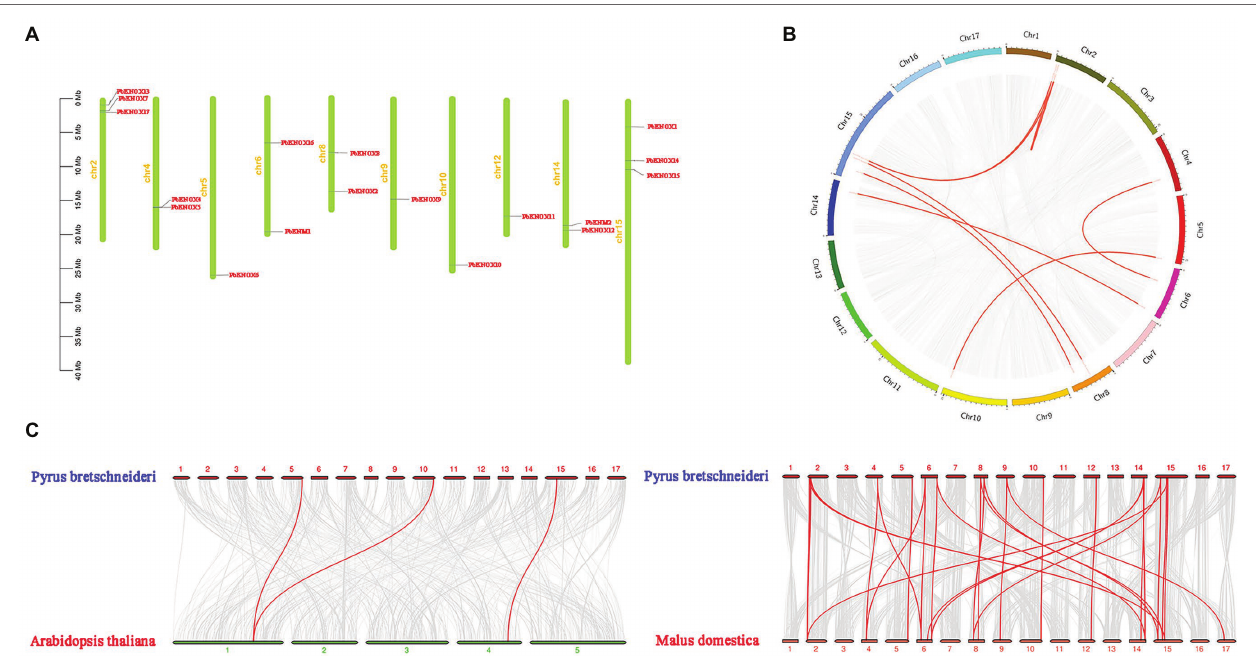
FIGURE 2 | Chromosomal distribution of PbKNOX genes drawn using MapChart v2.2. The scale represents chromosome length: 0–40 Mb (A) . Collinearity of KNOX s (B) . Distribution of segmentally duplicated PbKNOX genes on Pyrus bretschneideri chromosomes. Gray lines indicate collinear blocks in the whole Pyrus bretschneideri genome, and red lines indicate duplicated PbKNOX gene pairs. (C) Collinearity of Pyrus bretschneideri , Arabidopsis , and Malus domestica KNOX genes. Red lines indicate syntenic gene